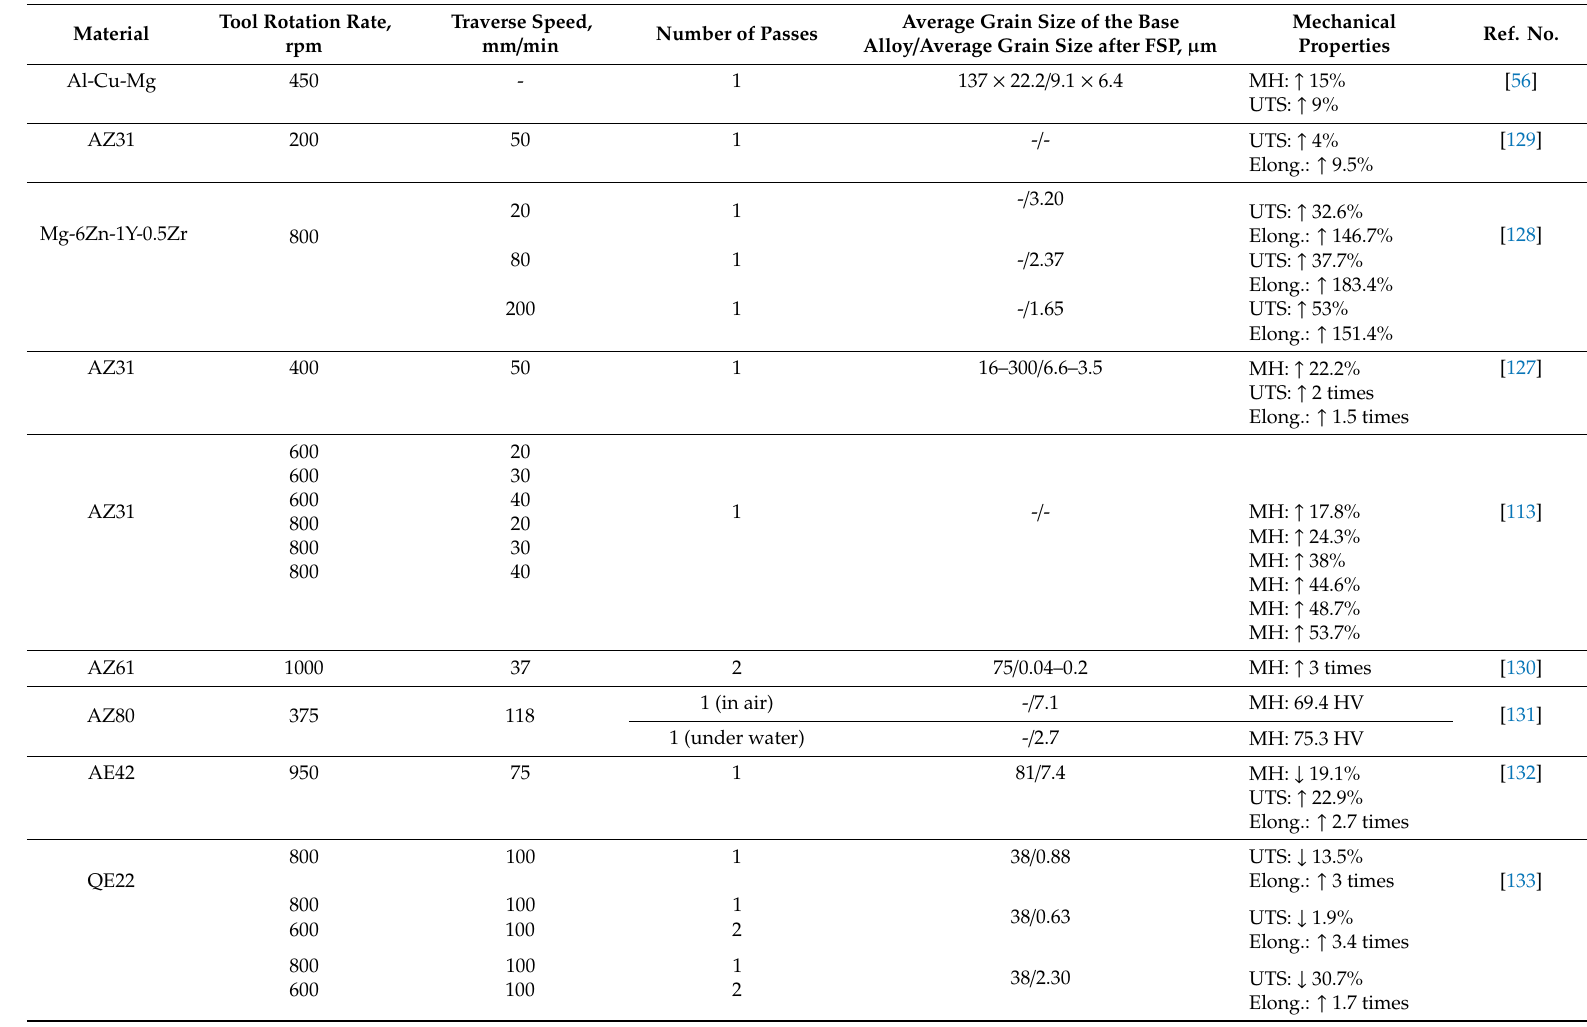
Table 4. Experimental data on FSP of magnesium